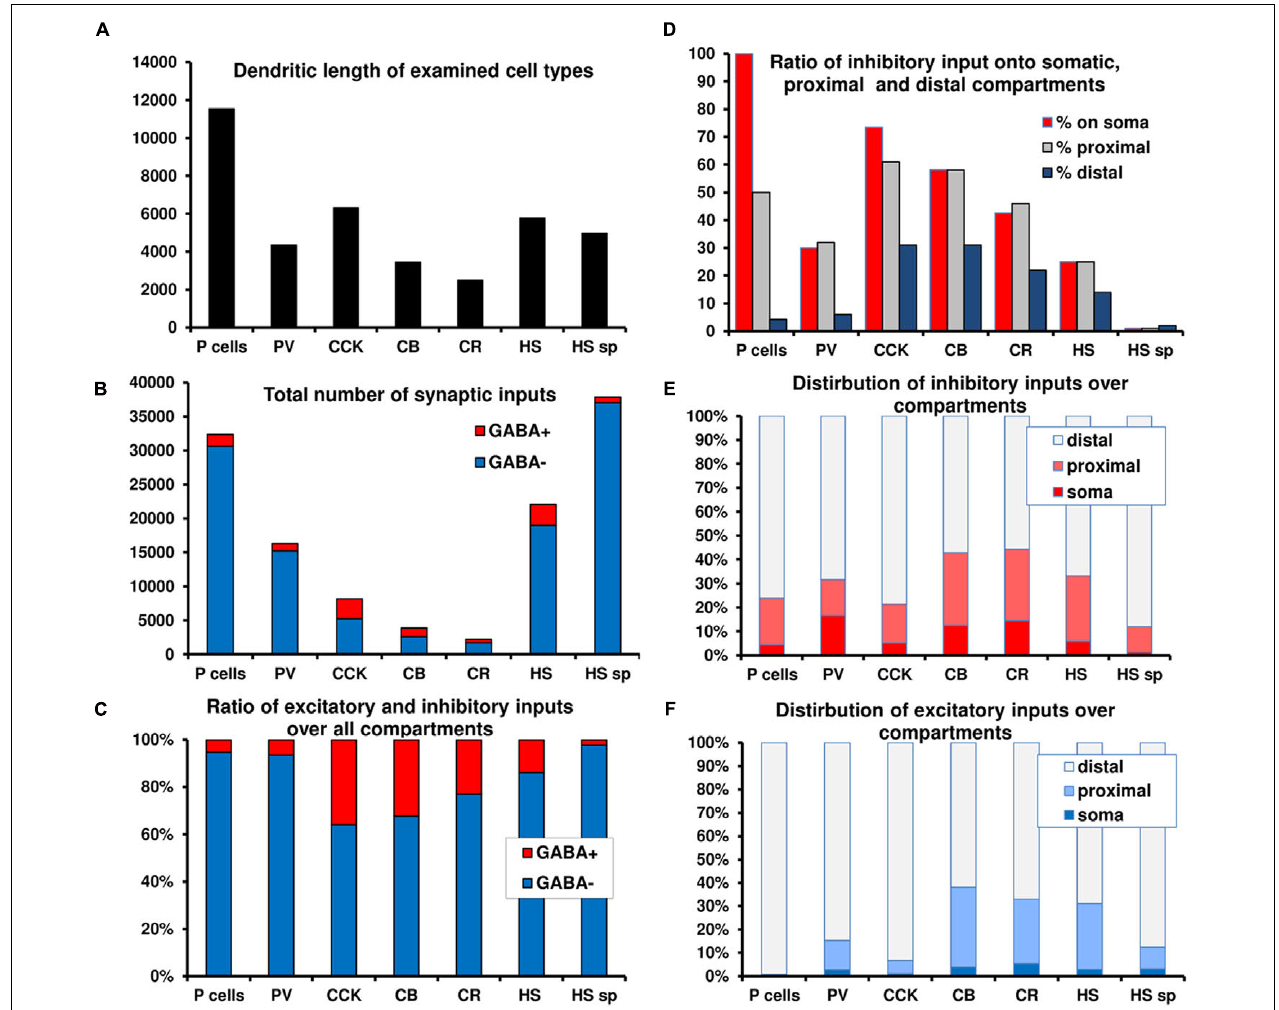
FIGURE 2 | Summary graphs of the distribution of excitatory and inhibitory inputs over different domains of CA1 neurons. (A–C) Total length, absolute and relative amount of excitation and inhibition over seven cell types. Note the large difference in the amount of converging inputs and in the ratio of inhibitory inputs. (D) Ratio of inhibitory inputs over different compartments of the cell types. Note the increase in the ratio of inhibition toward the soma, which, in the extreme case of PCs means that no excitation arrives somatically. (E–F) The distribution of excitatory and inhibitory inputs among compartments for the different cell types. A significant portion of inhibition arrives proximally for most neurons. In the case of PCs virtually all excitation arrives distally. The data presented in the figure is a summary of results from our earlier anatomical results (Gulyás et al., 1999; Megías et al., 2001; Mátyás et al., 2004; Takács et al.,